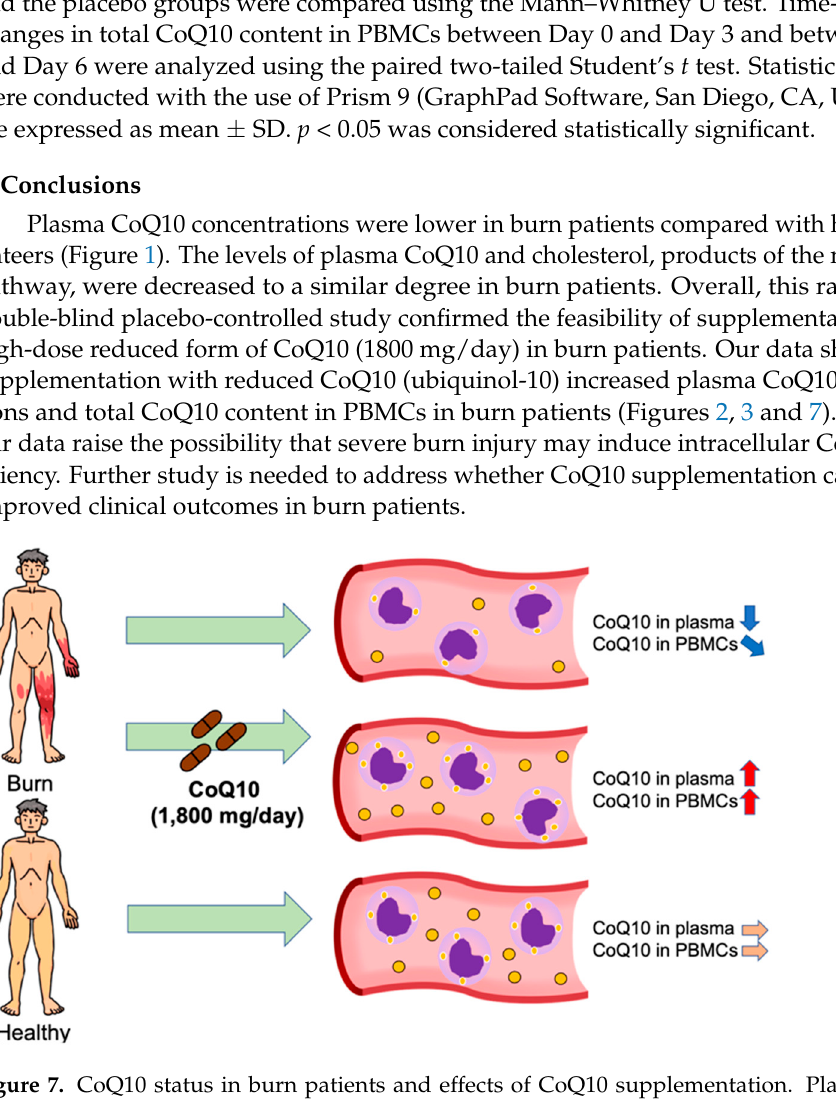
between healthy volunteers and burn patients of the placebo group on Day 3. Figure S4. Comparison of plasma CoQ10 status between healthy volunteers and burn patients of the on Day 3 and Day6.